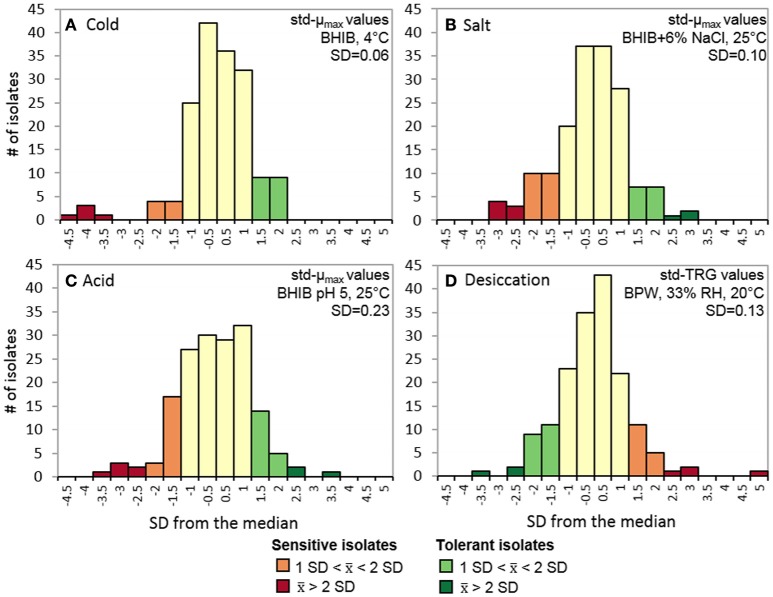
Stress tolerance distributions of 166 L. monocytogenes isolates. Std-μmax of isolates grown in (A) BHIB at 4°C, (B) BHIB+6% NaCl at 25°C, and (C) BHIB pH 5 at 25°C. (D) std-TRG of isolates after being desiccated at 33% RH for 3 days in BPW at 20°C and then rehydrated with BHIB and grown at 30°C. Isolates were classified as sensitive or tolerant if they displayed an average std-μmaxorstd-TRG >1 SD from the median (= 1). std-μmax, standardized maximum growth rate; std-TRG, standardized time to detectable regrowth; BHIB, brain heart infusion broth; BPW, buffered peptone water.